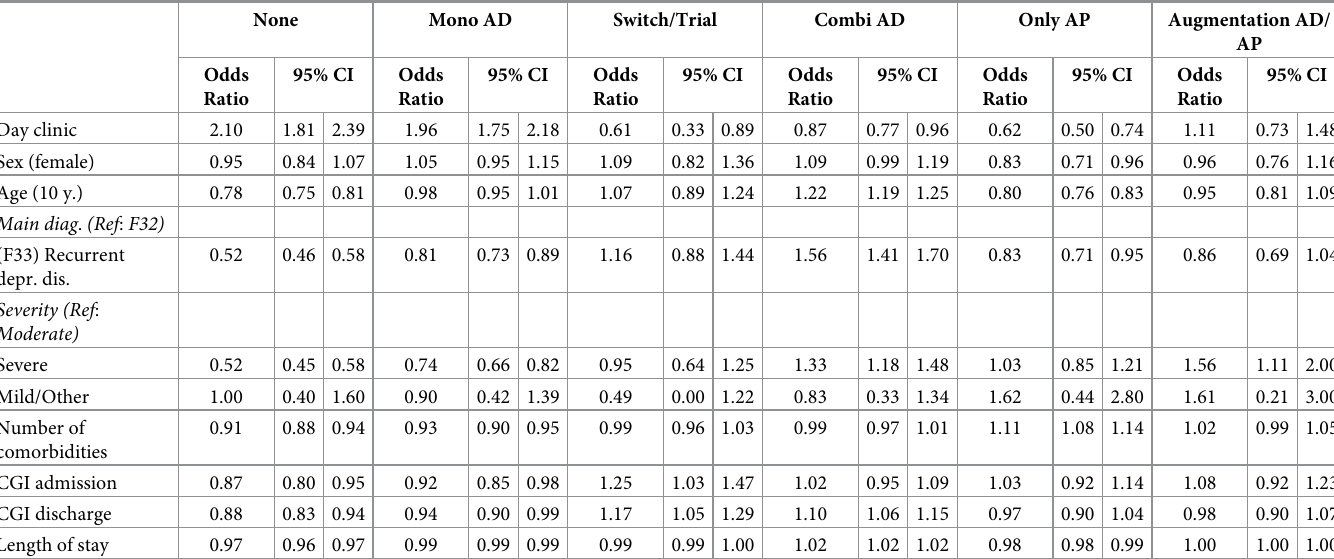
Table 2. Logistic regression models on the probability of receiving different antidepressant or and antipsychotic drug treatments. None Mono AD Switch/Trial Combi AD Only